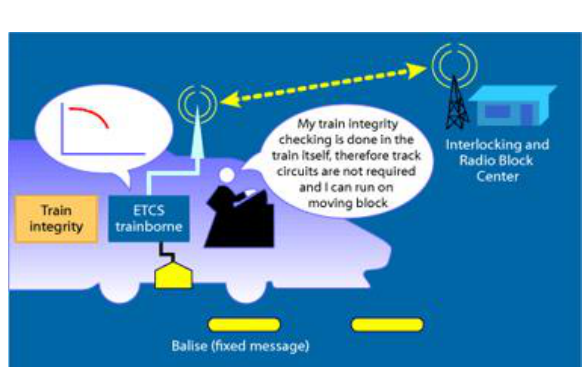
Figure 3. ETCS L3 [1]